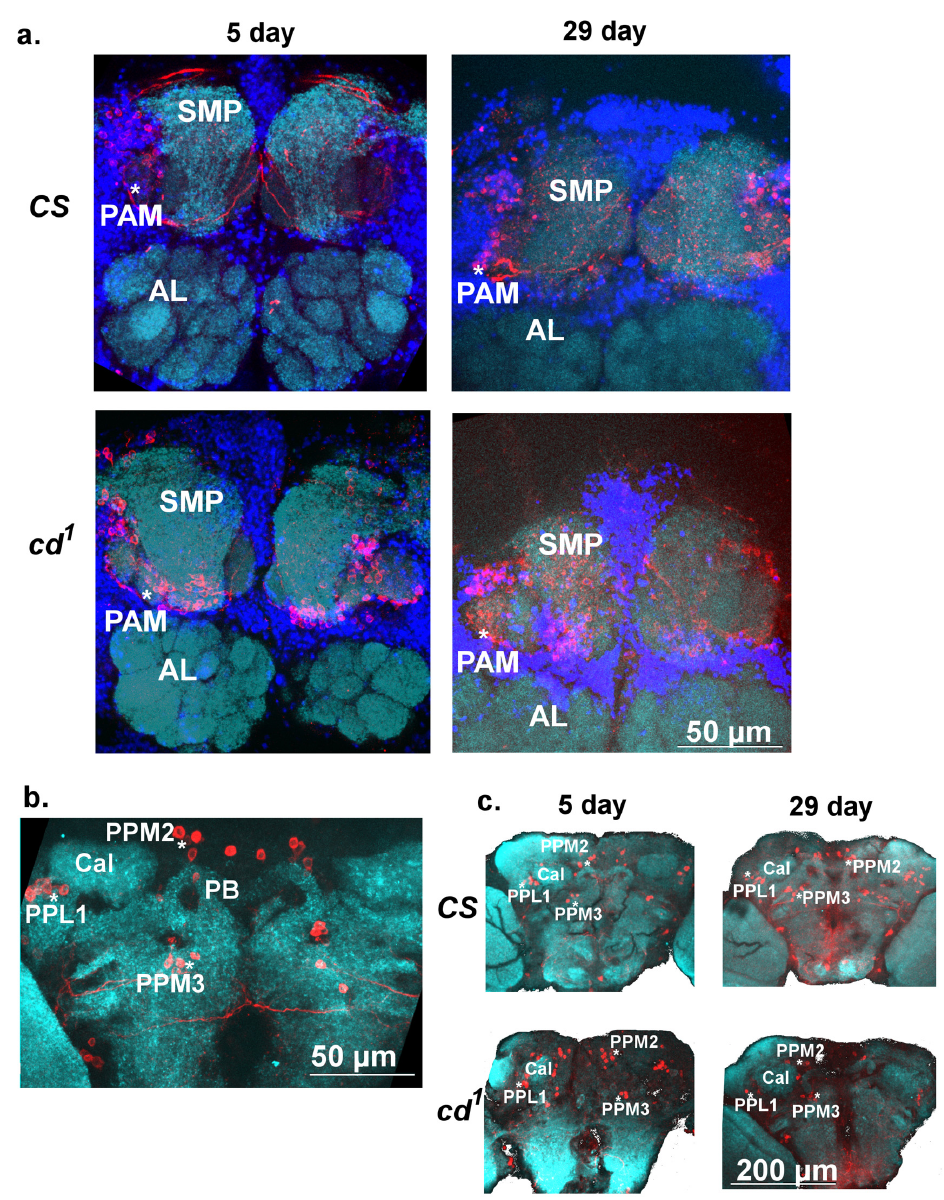
Figure 7. The tyrosine hydroxylase (TH)-positive clusters in the adult CS and cd 1 brains. ( a ). PAM clusters of young (5 day-old) and aged (29 day-old) CS and cd 1 (anterior side, X 63, scale bar 50 µ m). ( b ). PPL1, PPM2 and PPM3 clusters of 5-day-old CS (posterior side, X 63, scale bar 50 µ m). ( c ). PPL1, PPM2 and PPM3 clusters of young and aged CS and cd 1 (X 20, scale bar 200 μ m). Color scheme: cyan—neuropil (CSP); red—TH (DAN); blue—nuclei. AL—antennal lobe; Cal—calyx; PB—protocerebral bridge; SMP—superior medial protocerebrum. * TH-positive clusters. See abbreviations in the text.